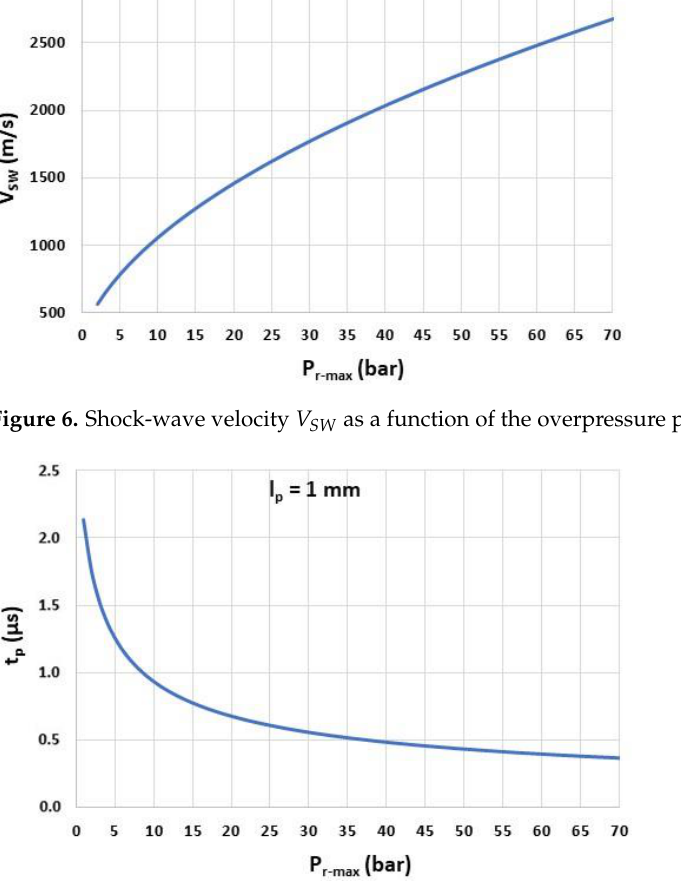
Figure 7. Travel time t P as a function of the overpressure peak P r − max ( l P = 1 mm).